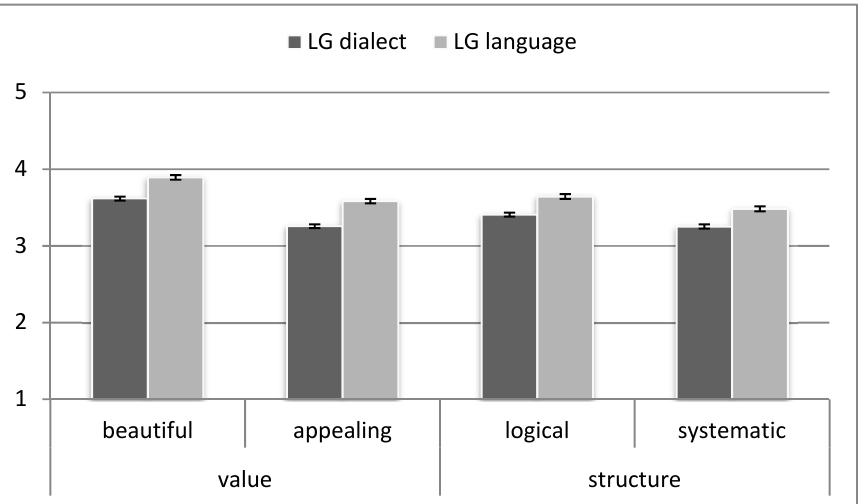
Figure 7. Evaluations of Low German (LG) by Low German’s status assessment (AToL scale, NGS2016).